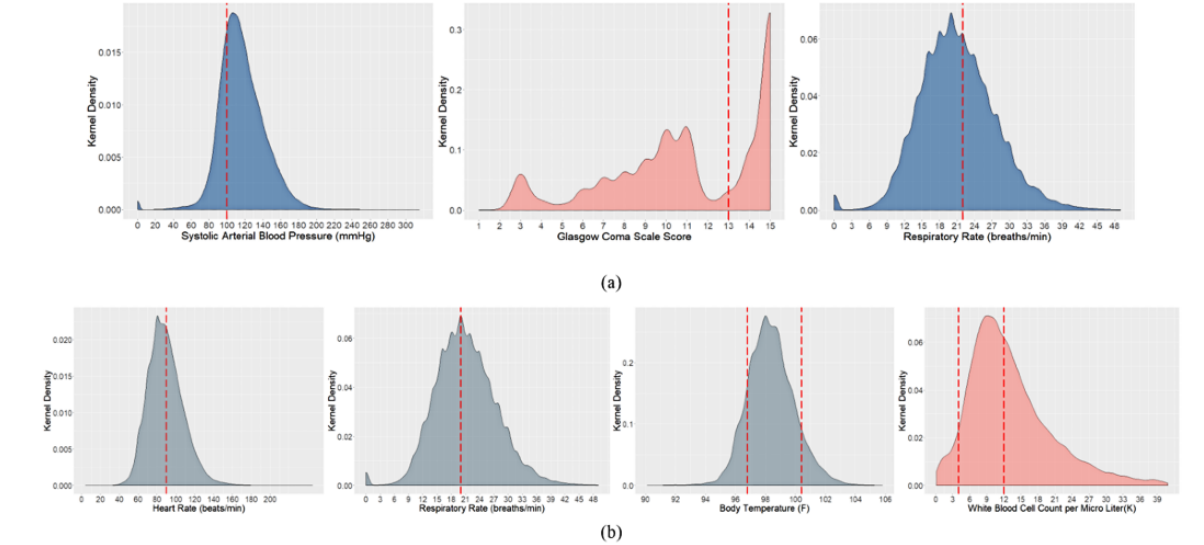
Figure 2. Kernel density estimation distribution of (a) quick Sequential Organ Failure Assessment (qSOFA) and (b) systemic inflammatory response syndrome (SIRS) parameters to understand the prevalence of each